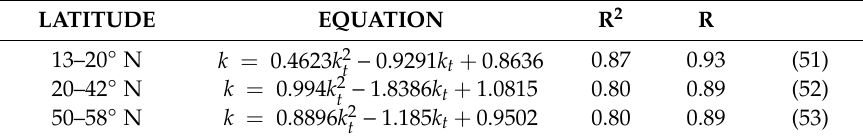
Table 6. Monthly-Averaged Hourly Di ff use Irradiation Table 6. Monthly ‐ Averaged Hourly Diffuse Irradiation Equations.